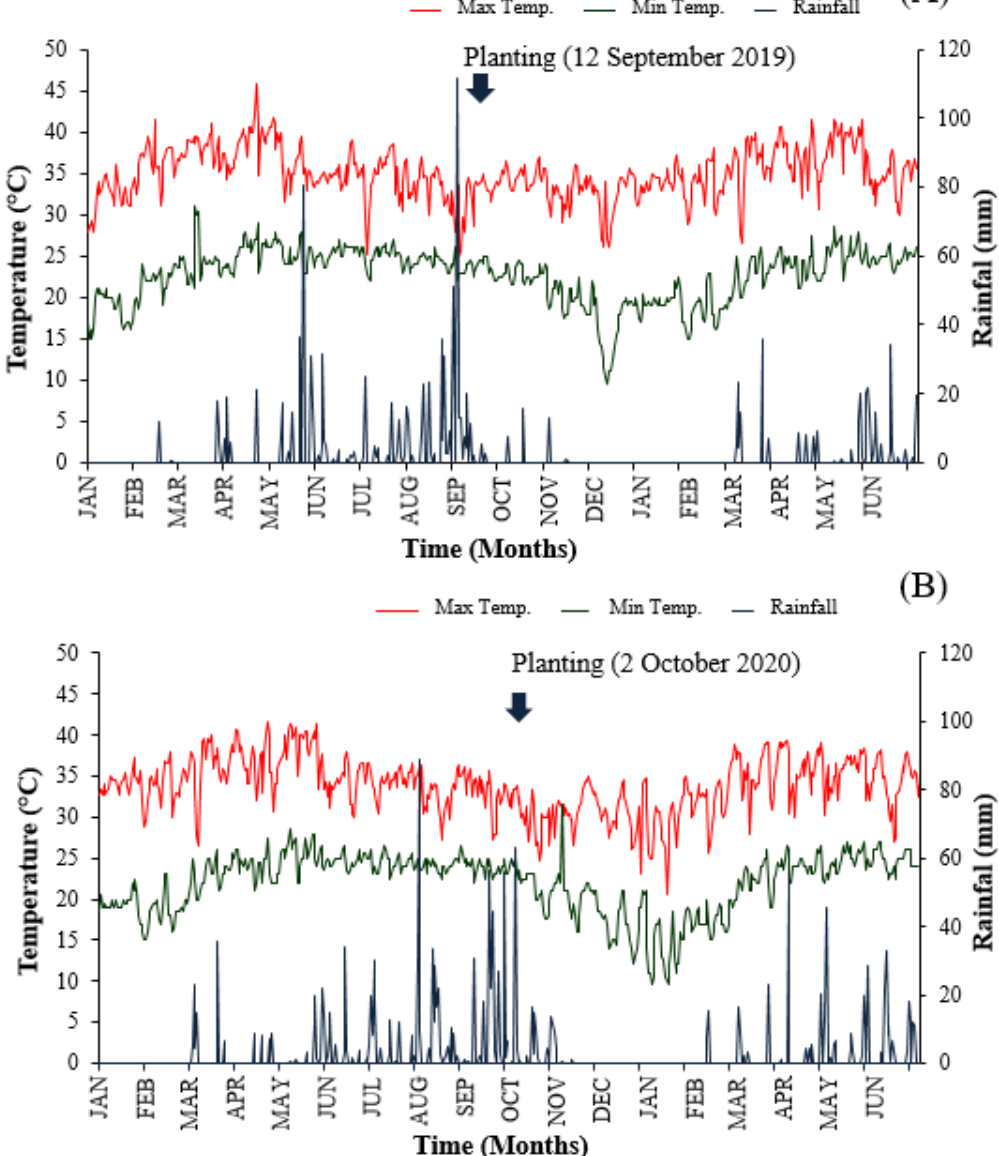
Figure 2. Average rainfall and the maximum and minimum temperatures during the 2019-2020 ( A ) and 2020-2021 ( B ) experiments in Northeast Thailand (Khon Kaen).